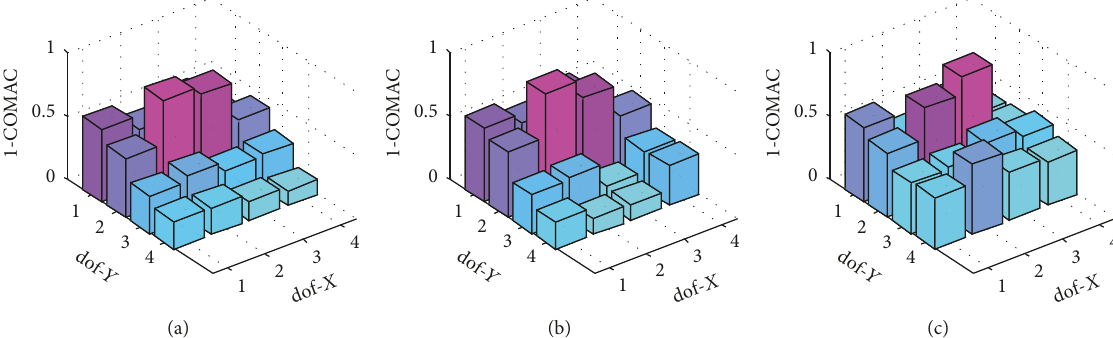
Figure 4: Effect of the noise in COMAC calculated for DS3 versus DS0 for a 16-dof model. (a) 0% noise, (b) 5% noise, and (c) 10%